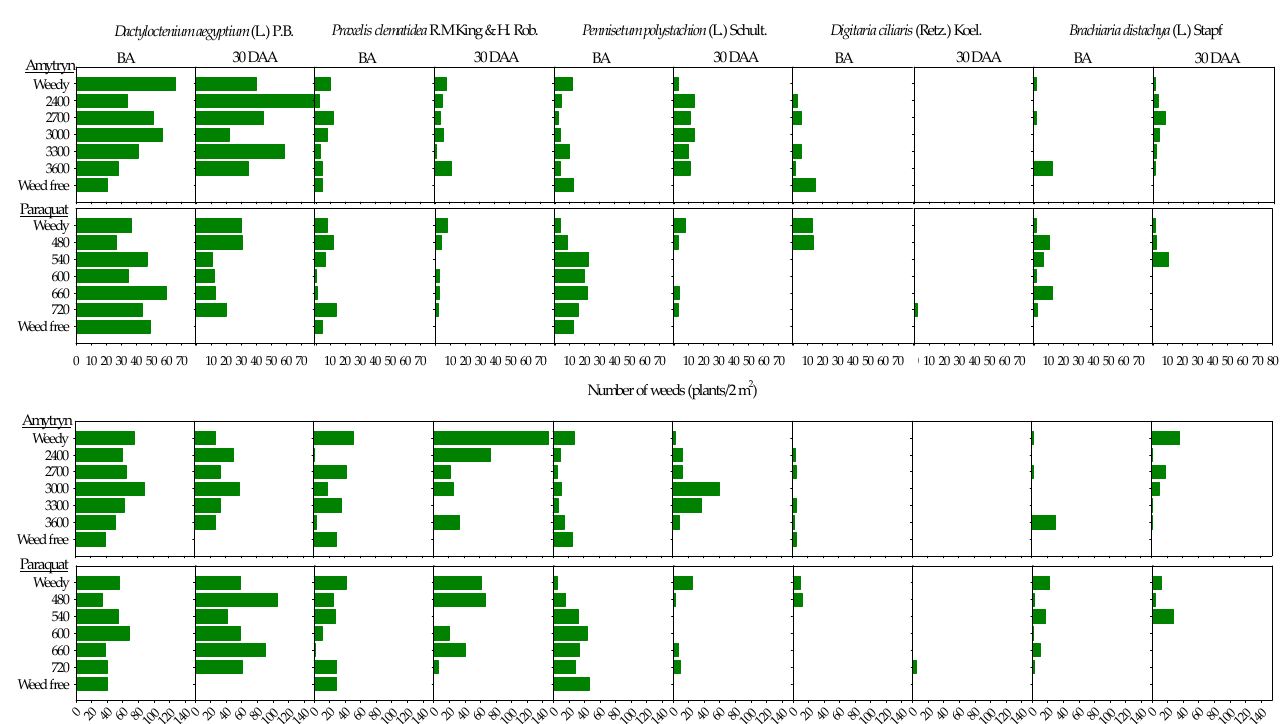
Figure 5. Effects of ametryn and paraquat applications on the number of weeds and biomass of the top-five weed species in Experiment I at before application (BA), and 30 days after application (DAA). The data measured from 2 m 2 , not statistically analyzed. The green bars represent number and biomass of individual weed species.